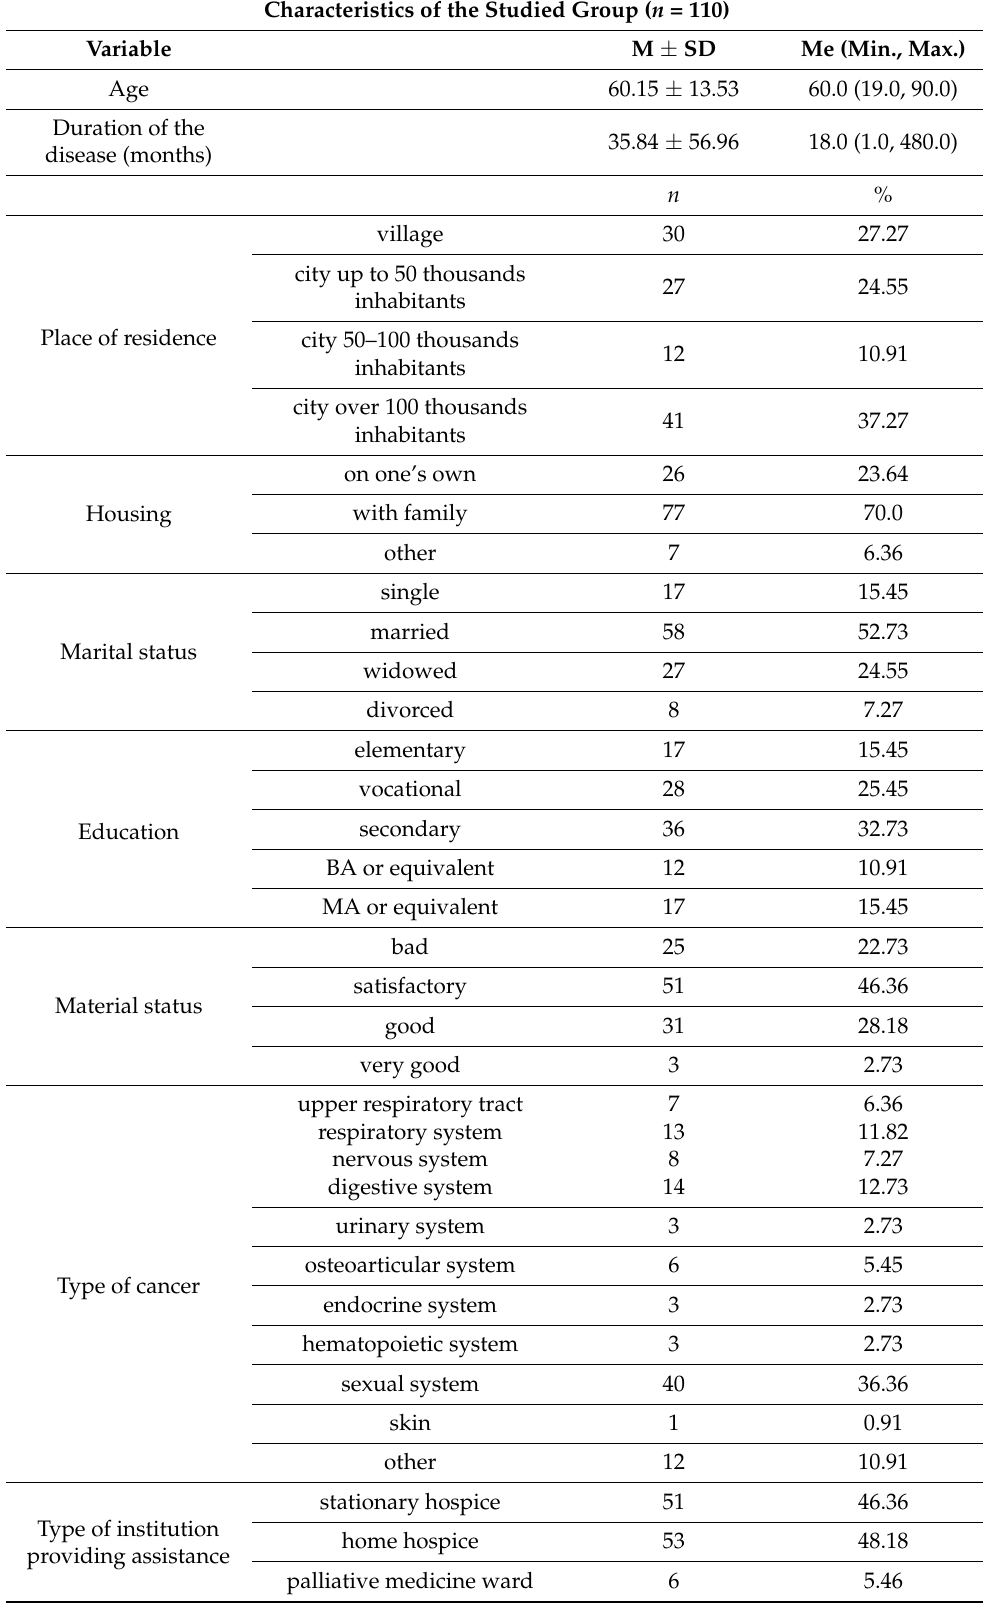
Table 1. Characteristics of the studied group. Characteristics of the Studied Group ( n =